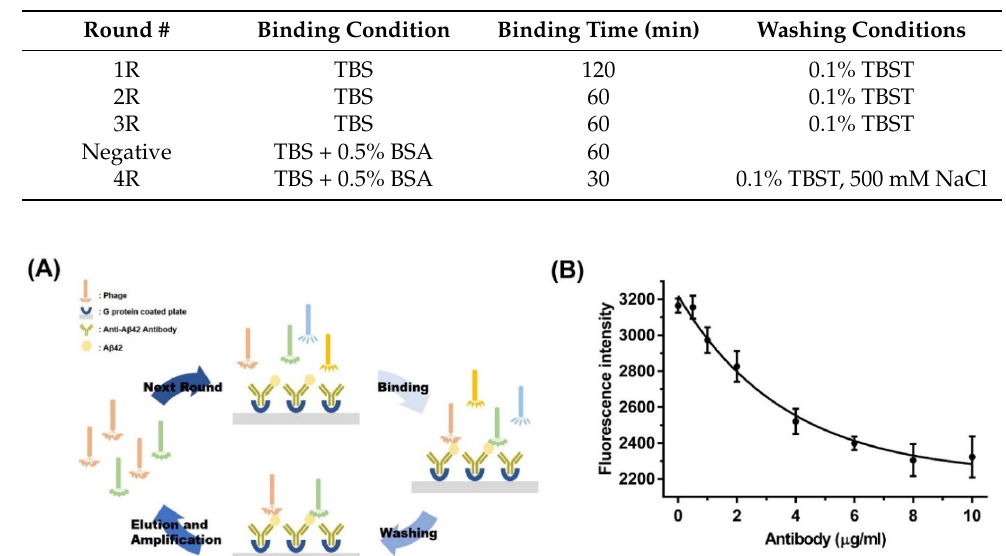
Table 1. Conditions of phage display.